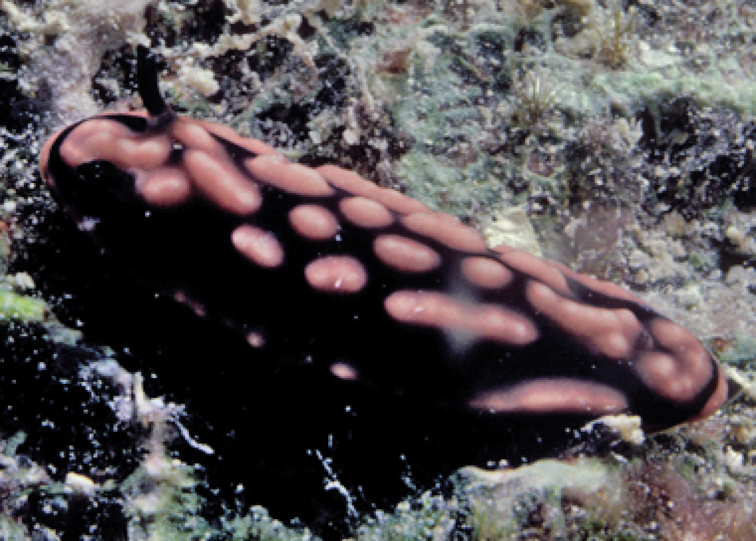
Phyllidiella striata, 20 mm, Maldives, photo: N Yonow.